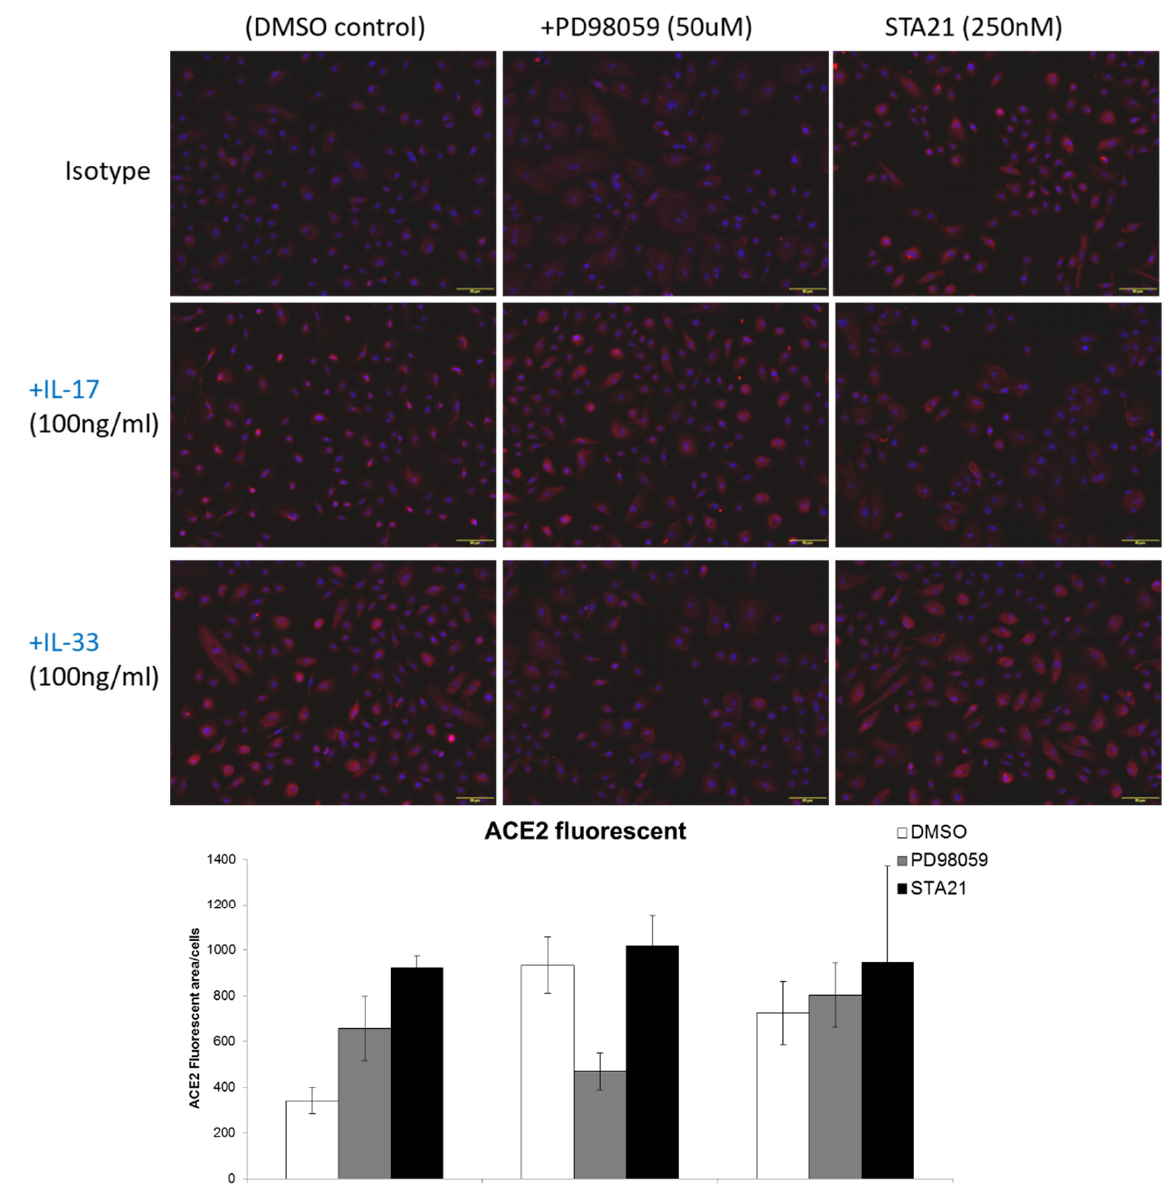
Figure 4. IL-33 enhanced ACE2 expression through ERK in keratinocytes. We performed immunofluorescent staining to measure the ACE2 expression in IL-33-treated keratinocytes. Small molecule inhibitors for PD98059 or STA21 (ERK and STAT3, respectively) were also pretreated. In the DMSO control, the fluorescence intensity of ACE2 (red color) was enhanced by IL-33 ( bottom left ). The fluorescence intensity decreased after PD98059 pretreatment ( bottom middle ). This phenomenon was not revealed after STA21 pretreatment ( bottom right ). Red: ACE2; blue: DAPI. The bar graph shows the quantitative data. In the DMSO control (white bar), the value of fluorescent area per cell increased under IL-33 stimulation. Moreover, under IL-33 stimulation (middle histogram), the value dramatically decreased after PD98059 pretreatment (gray bar), but not after STA21 pretreatment (black bar).